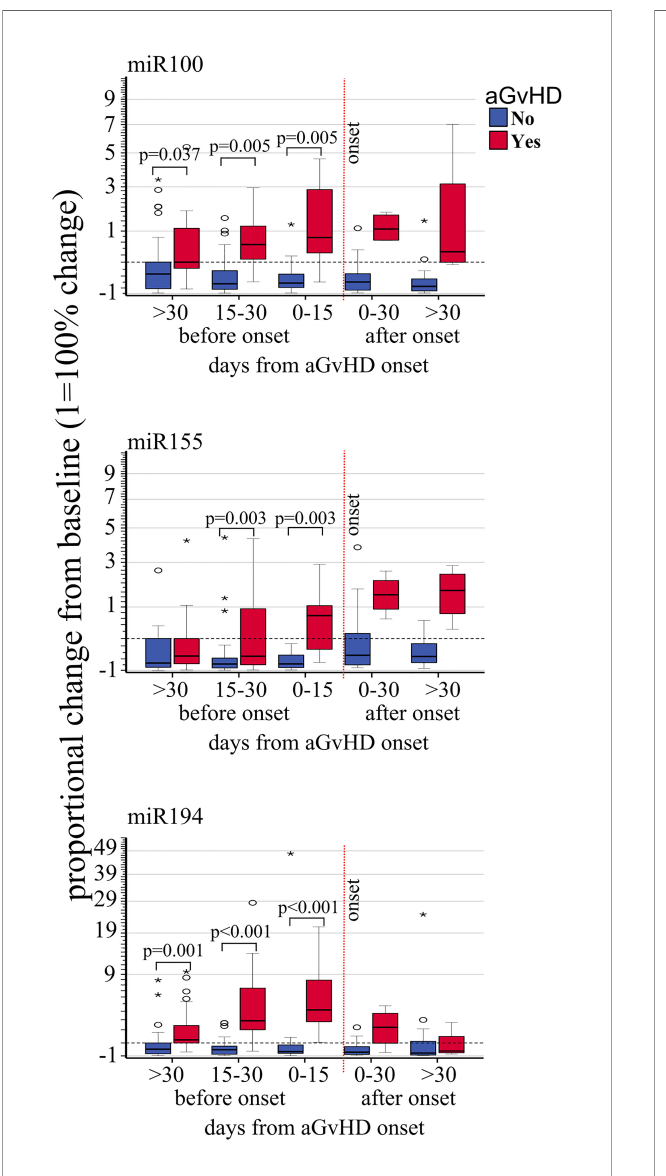
FIGURE 3 | Impact of acute GvHD onset on the kinetics of EV miRNA. Proportional change of miR100, miR155, and miR194 (from top to bottom) quanti fi ed by real-rime PCR from precipitated EVs at different time points before and after aGvHD onset and compared to the pre-transplant baseline values. Dash black line: pre-transplant levels; dashed red line: time of aGvHD onset; circle and star dots represent outliers (>1.5 box length from median) and extreme values (>3 box length from median), respectively. Signi fi cant mean differences before the onset (p ≤ 0.05) between patients with aGvHD (red) and without (blue) are indicated.